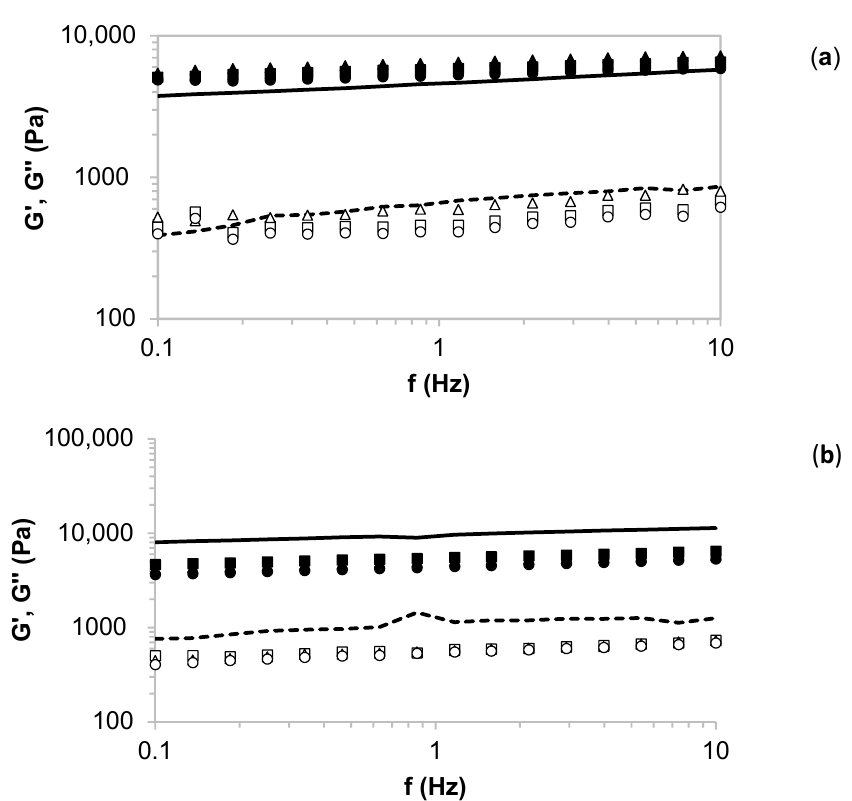
Figure 5. Impact of the extraction treatment of artichoke bracts (( a ), conventional and ( b ), microwave) on the oscillatory measurements of starch-based hydrogels formulated with autohydrolysis extracts of artichoke and Paulownia leaves at different volume ratios. Symbols: G’ (closed), G’’ (open), 25:75 (squares), 50:50 (triangles), 75:25 (circles), and 100:0 (lines).